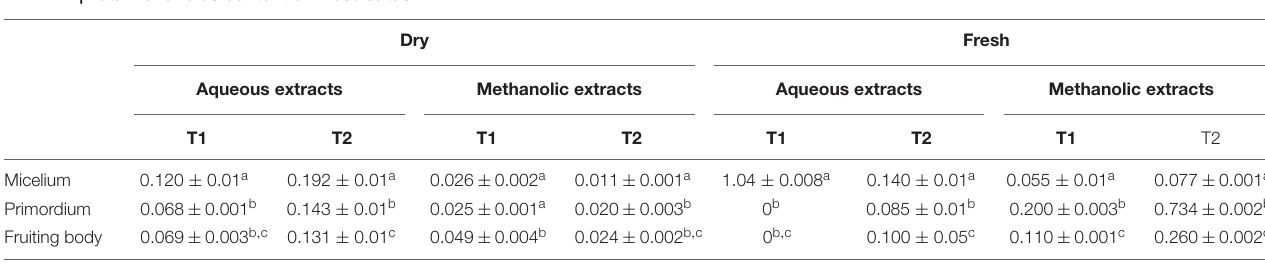
TABLE 2 | Total flavonoids content of P. ostreatus.